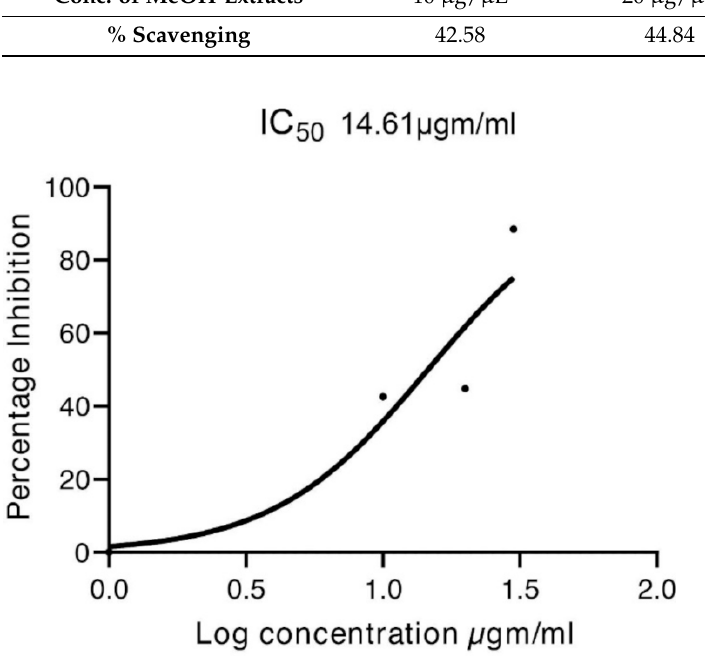
Figure 7. Calibration curve.